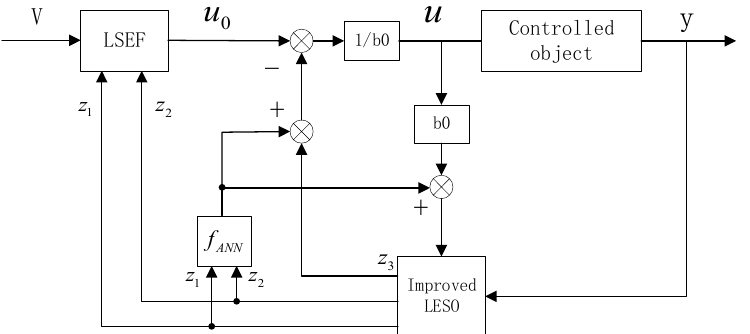
Figure 7. Block diagram of ANN-LADRC control structure.